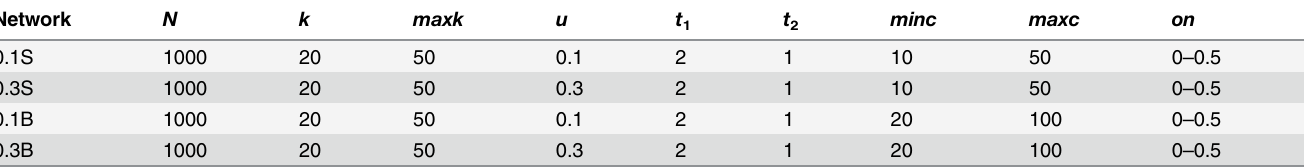
Table 1. The detailed parameters of LFR benchmark